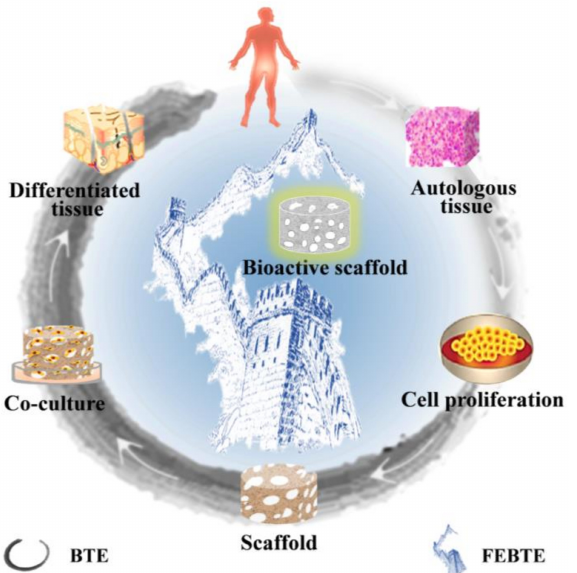
Figure 2. Comparison of two bone repair strategies. Traditional bone tissue engineering (BTE) needs tissue harvest, cell isolation and co-culture with a scaffold ex vivo, while facilitated endogenous bone tissue engineering (FEBTE) avoids these tedious and risky procedures by using a bioactive